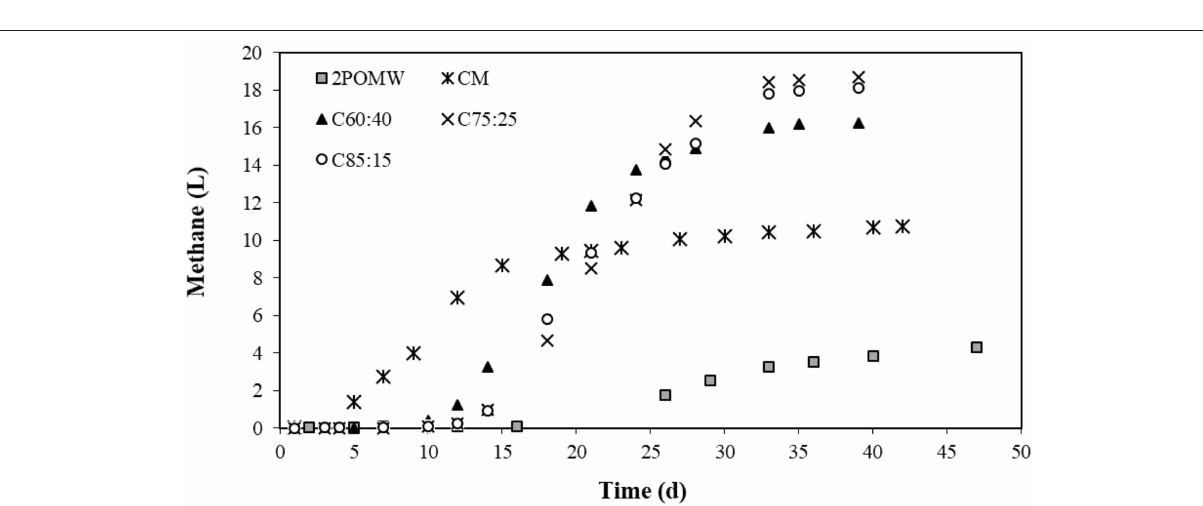
concentrations were between 1.09 and 1.25 g/L for